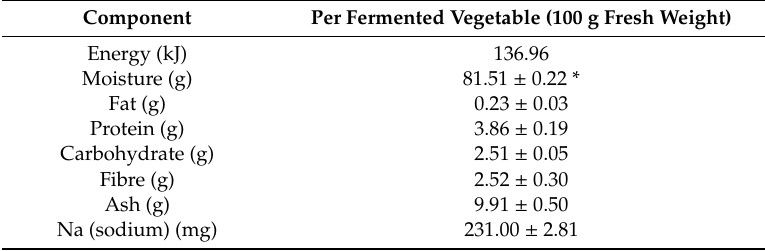
Table 2. Proximate analysis data of the nightshade leaves fermented with L. plantarum strain 75